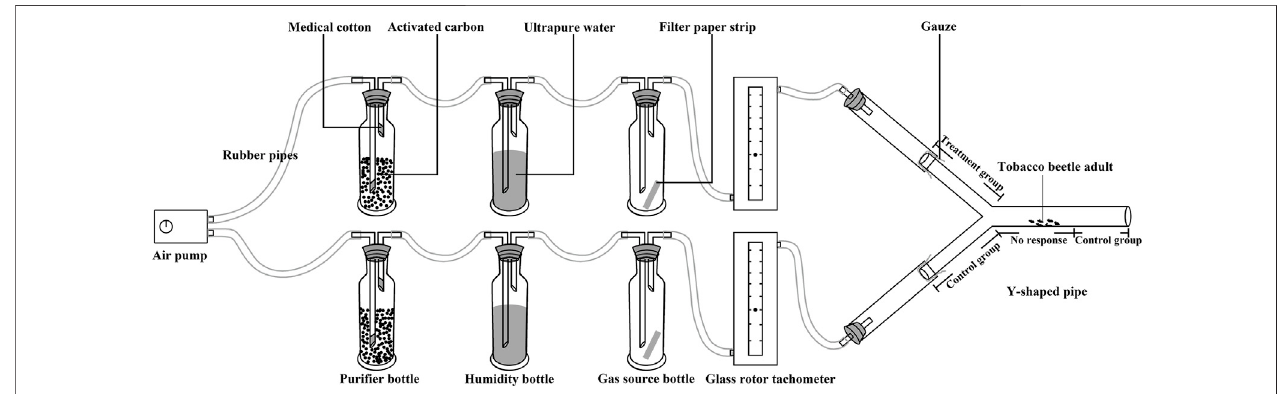
FIGURE 1 | The diagram for the behavioral test on tobacco beetle